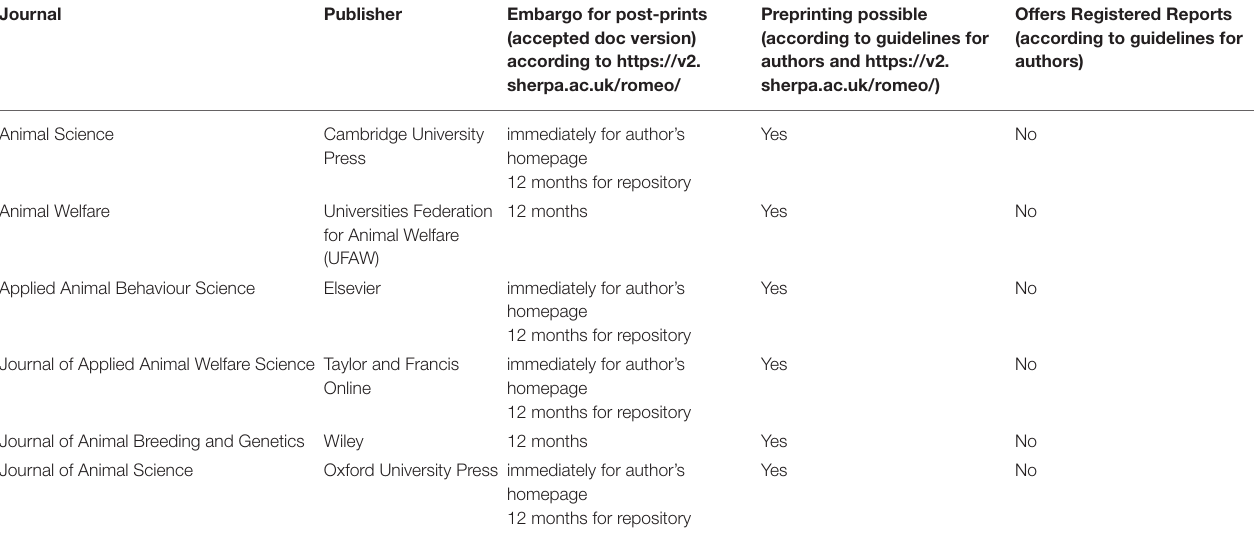
TABLE 1 | Current Open Science practices in animal science journals (compiled 01/2022)–a brief overview: we selected an exemplary and non-representative sample of Hybrid Open Access journals that represent different publishers and cover animal science while not specialized to a certain animal